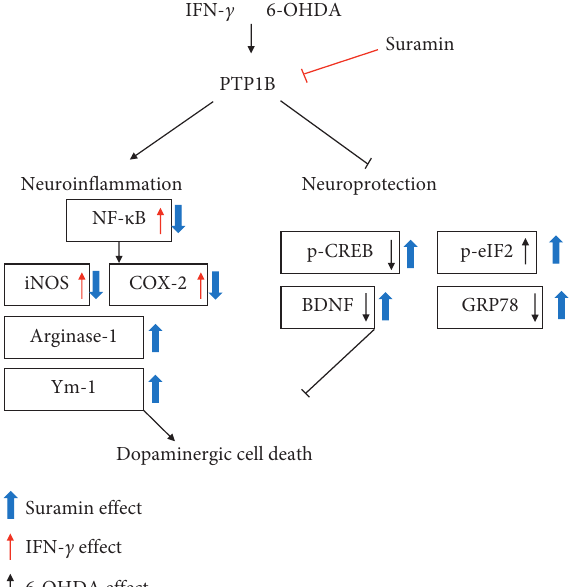
Figure 8: Schematic diagram of PTP1B in IFN- c -induced neuroinflammation and 6-OHDA-induced neuronal death. IFN- c could increase PTP1B expression and further modulate downstream cascade, including the upregulation of proinflammatory cytokines, such as iNOS, COX-2, and NF- κ B. Treatment of 6-OHDA could also affect PTP1B and its downstream neuroprotection-related pathway, including the downregulation of p-CREB, GRP-78, and BDNF and upregulation of p-eIF2. Our study revealed that the PTP1B inhibition by suramin could reverse IFN- c -induced upregulation of iNOS and COX-2 protein expression. Moreover, suramin could modulate M2 type microglia-related protein and increase arginase-1 and Ym-1 protein expression. PTP1B inhibition also reversed the 6-OHDA-induced downregulation of p-CREB and BDNF protein expression. In the anti-ER stress section, suramin further enhanced 6-OHDA-induced upregulation of p-eIF2 expression and reversed 6- OHDA-induced downregulation of GRP-78 expression. The effect of suramin significantly protected dopamine neurons against